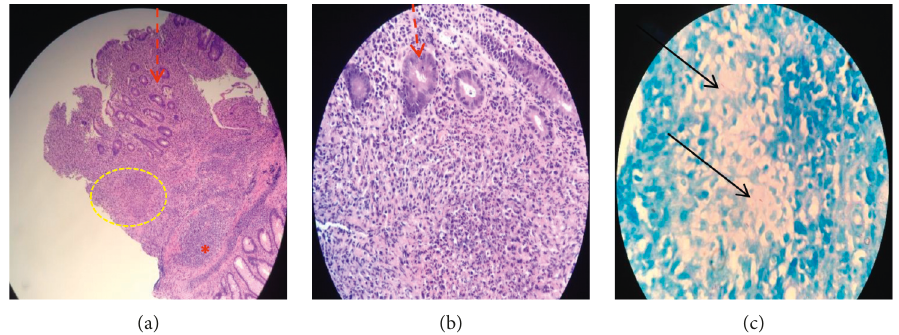
Figure 3: Colonic biopsies. (a) Lamina propria shows expansion by inflammatory cells. A lymphoid aggregate (red asterix), nonneoplastic colonic glands (red dashed arrow), and granuloma are seen (yellow dashed line) (hematoxylin and eosin, original magnification x100). (b) Goblet mucin component decreased as well as cryptitis. Edge of granuloma is seen here (original magnification x200). (c) Acid-fast bacilli (black arrows) (Ziehl–Neelsen